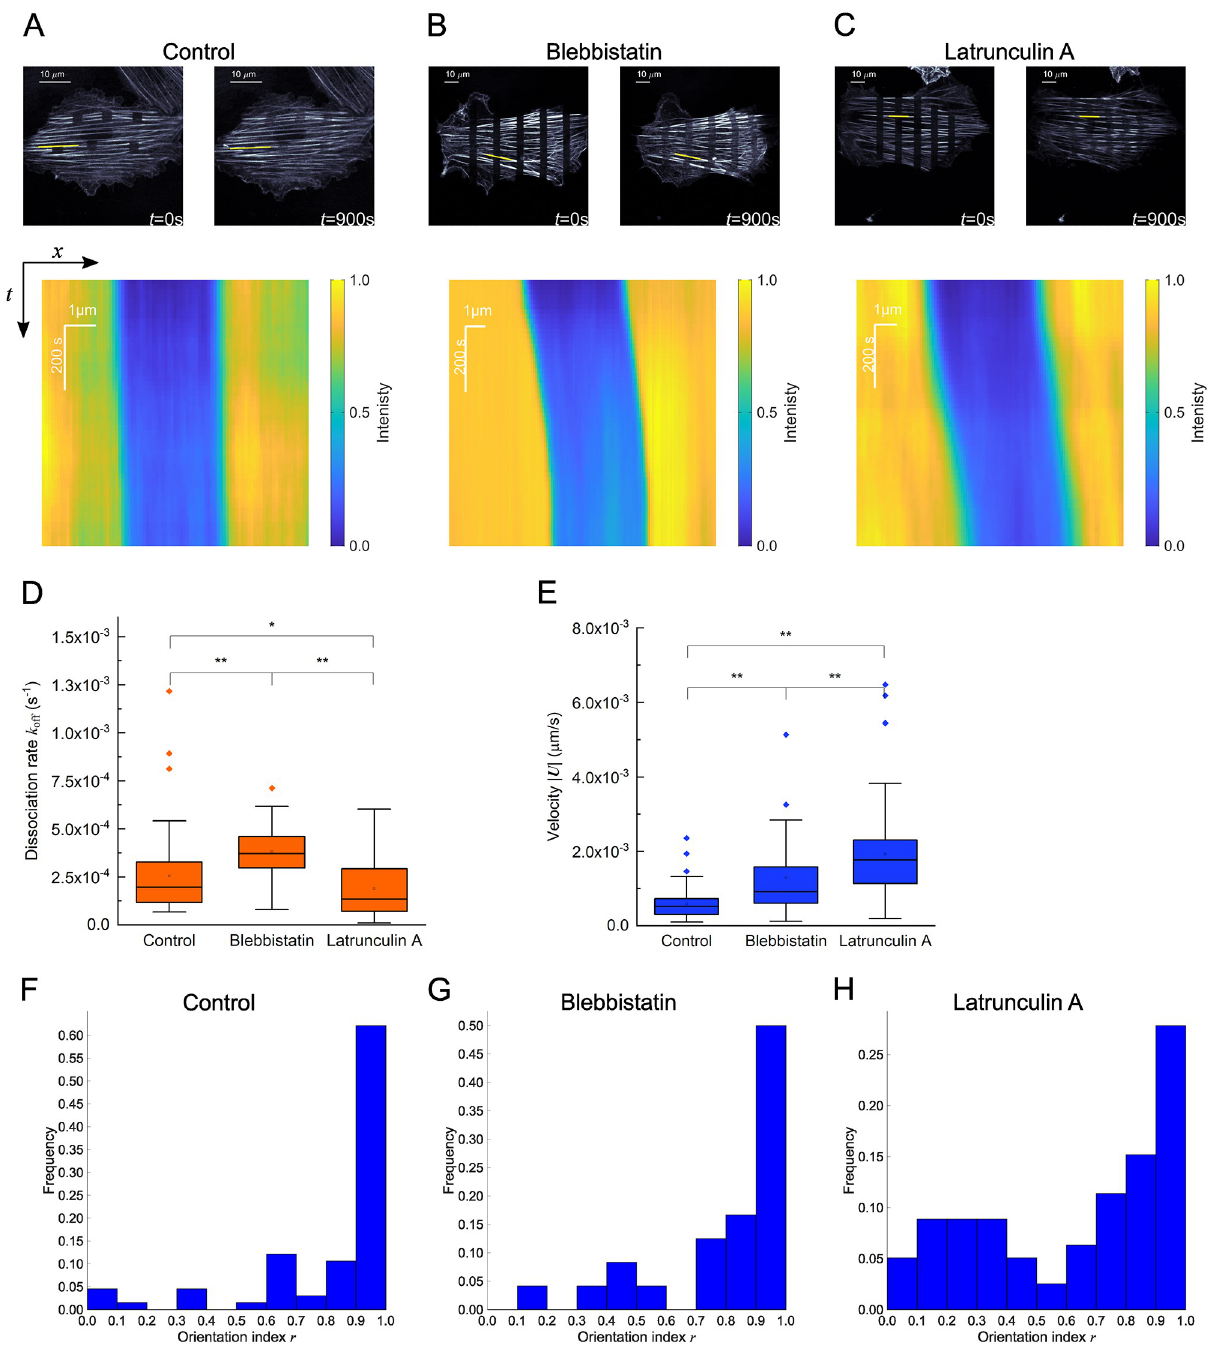
Fig 5. The effect of actin–myosin interaction and actin polymerization on the inherent properties of actin on SFs and intracellular advection. (A – C) Cells expressing mClover2-tagged β -actin and undergoing FRAP at vehicle control ( A ), Blebb ( B ), and LatA ( C ) conditions. Kymographs of the fluorescence intensity along the specified yellow lines are shown below for each condition. (D), (E) The dissociation rate ( D ) and advection velocity ( E ) of actin on SFs for each condition shown by mean ± SD ( n = 66, 24, and 52 regions of interest for vehicle control, Blebb, and LatA conditions, respectively, from at least 3 independent experiments). Box and whisker plots show the following: The upper and lower edges of the boxes represent the 75 and 25 percentile ranges, respectively; the central lines represent the median; the whiskers represent the standard deviation; the open dots represent the mean; and, the closed dots represent outliers. The asterisks indicate significant differences. (F) – (H) The histogram of the orientation index that describes the correlation in the directions of SFs and advection velocity vectors for vehicle control ( F ), Blebb ( G ), and LatA ( H ) conditions ( n = 66, 24, and 52 regions of interest for vehicle control, Blebb, and LatA conditions, respectively, from at least 3 independent experiments). Scale, 10 μ